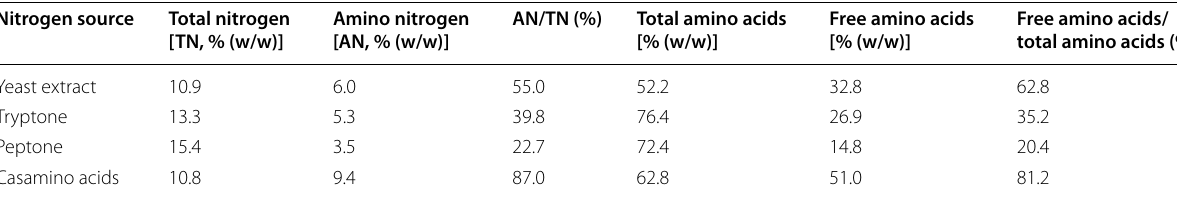
Table 4 Compositions of various nitrogen-containing sources Nitrogen